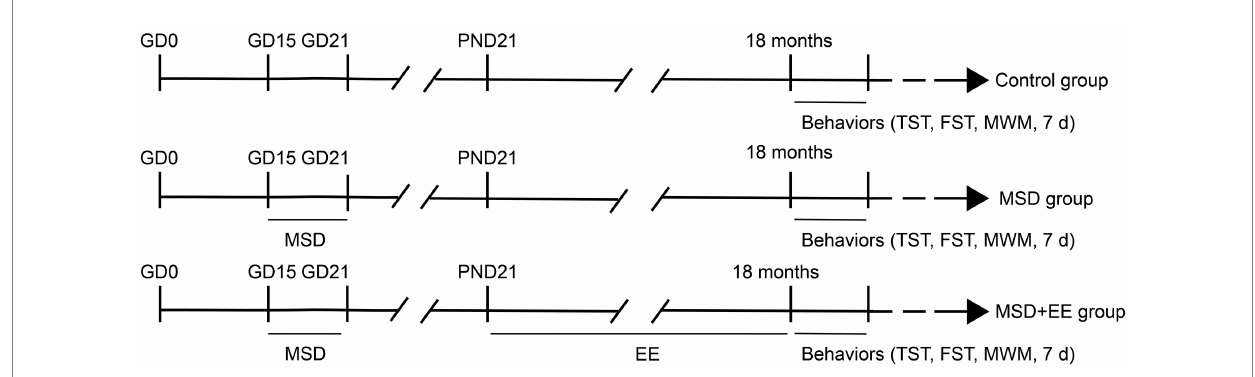
FIGURE 1 Experimental protocol. GD, gestational day; PND, postnatal day; MSD, maternal sleep deprivation; EE, environmental enrichment; TST, tail suspension test; FST, forced swimming test; MWM, Morris water maze